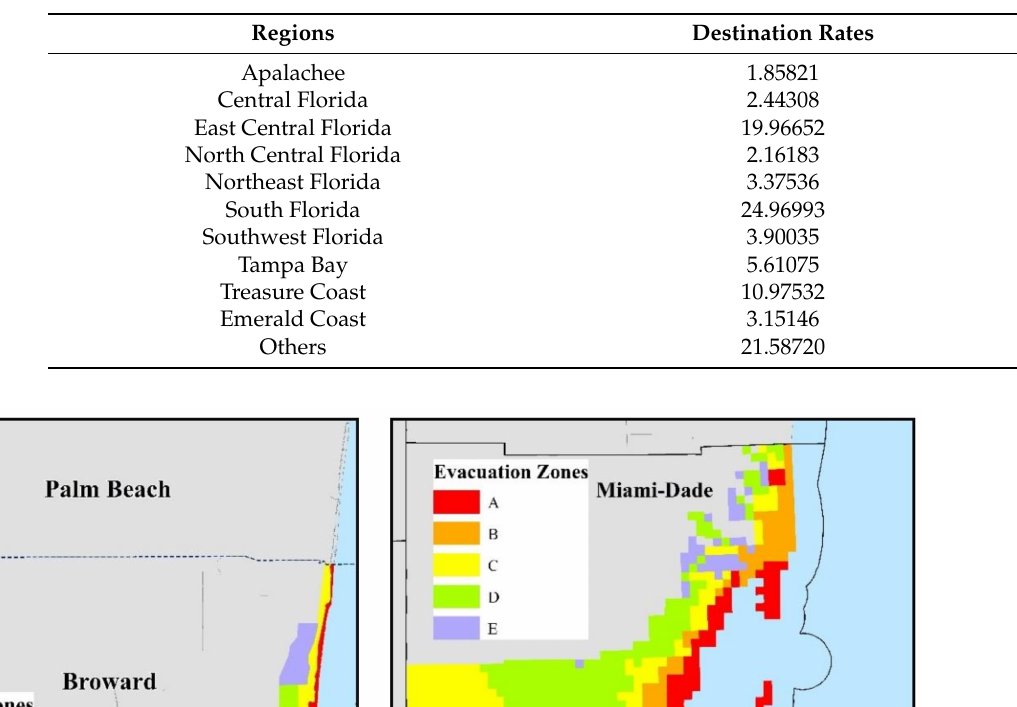
Table 2. Regional destination rates.